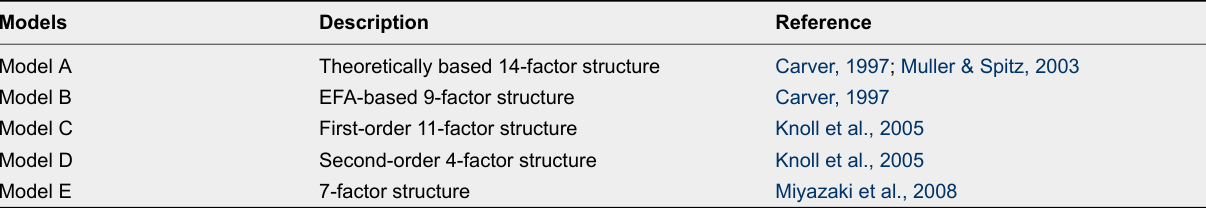
The Five Compared Models, Descriptions, and